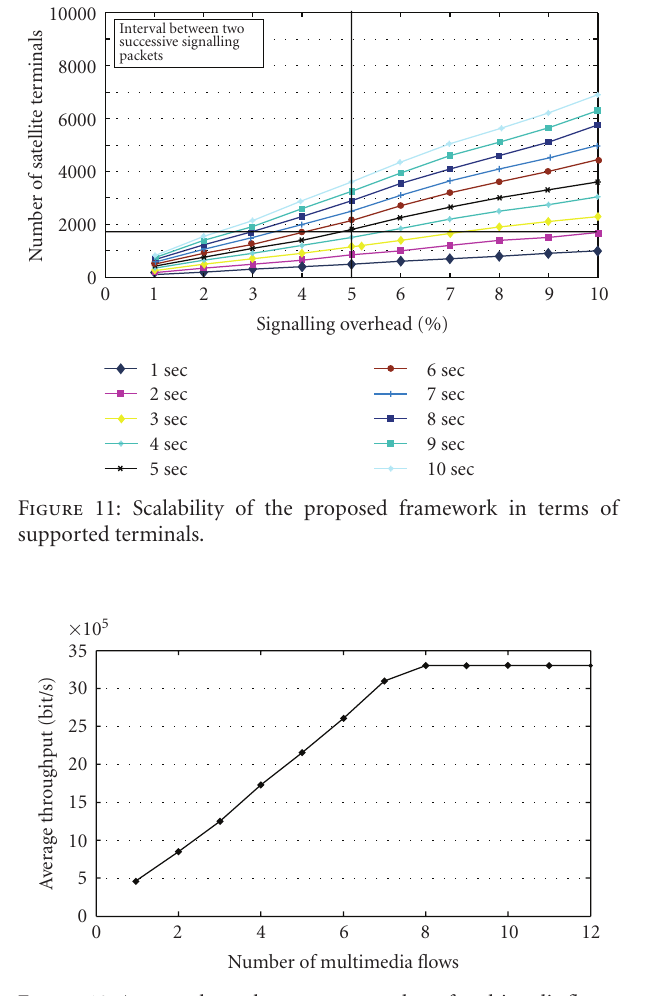
Figure 12: Average throughput versus number of multimedia flows.